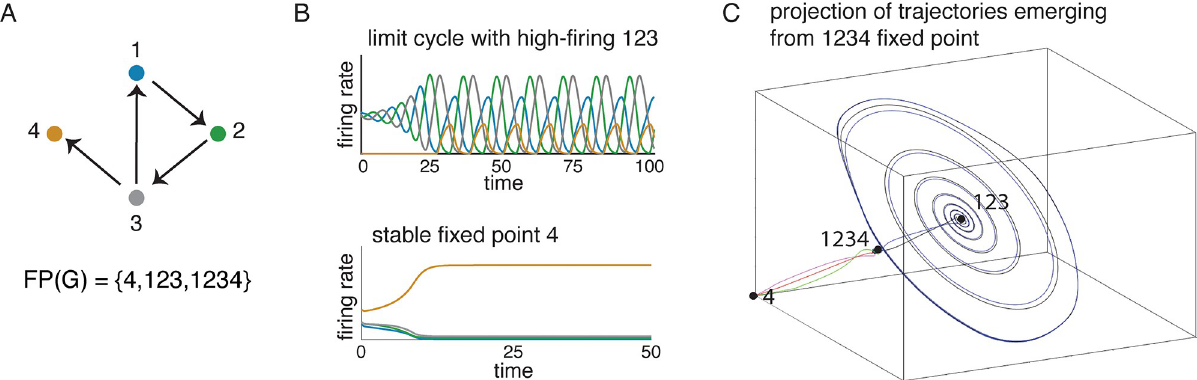
Fig 3. An example CTLN and its attractors. (A) The graph of a CTLN. Using graph rules, we can compute FP( G ). (B) Solutions to the CTLN with the graph in panel A using the standard parameters θ = 1, ε = 0.25, and δ = 0.5. (Top) The initial condition was chosen as a small perturbation of the fixed point supported on 123. The activity quickly converges to a limit cycle where the high-firing neurons are the ones in the fixed point support. (Bottom) A different initial condition yields a solution that converges to the static attractor corresponding to the stable fixed point on node 4. (C) The three fixed points are depicted in a three-dimensional projection of the four-dimensional state space. Perturbations of the fixed point supported on 1234 produce solutions that either converge to the limit cycle shown in panel B, or to the stable fixed point. This fixed point thus lives on the boundary of the two basins of attraction, and behaves as a “tipping point” between the two